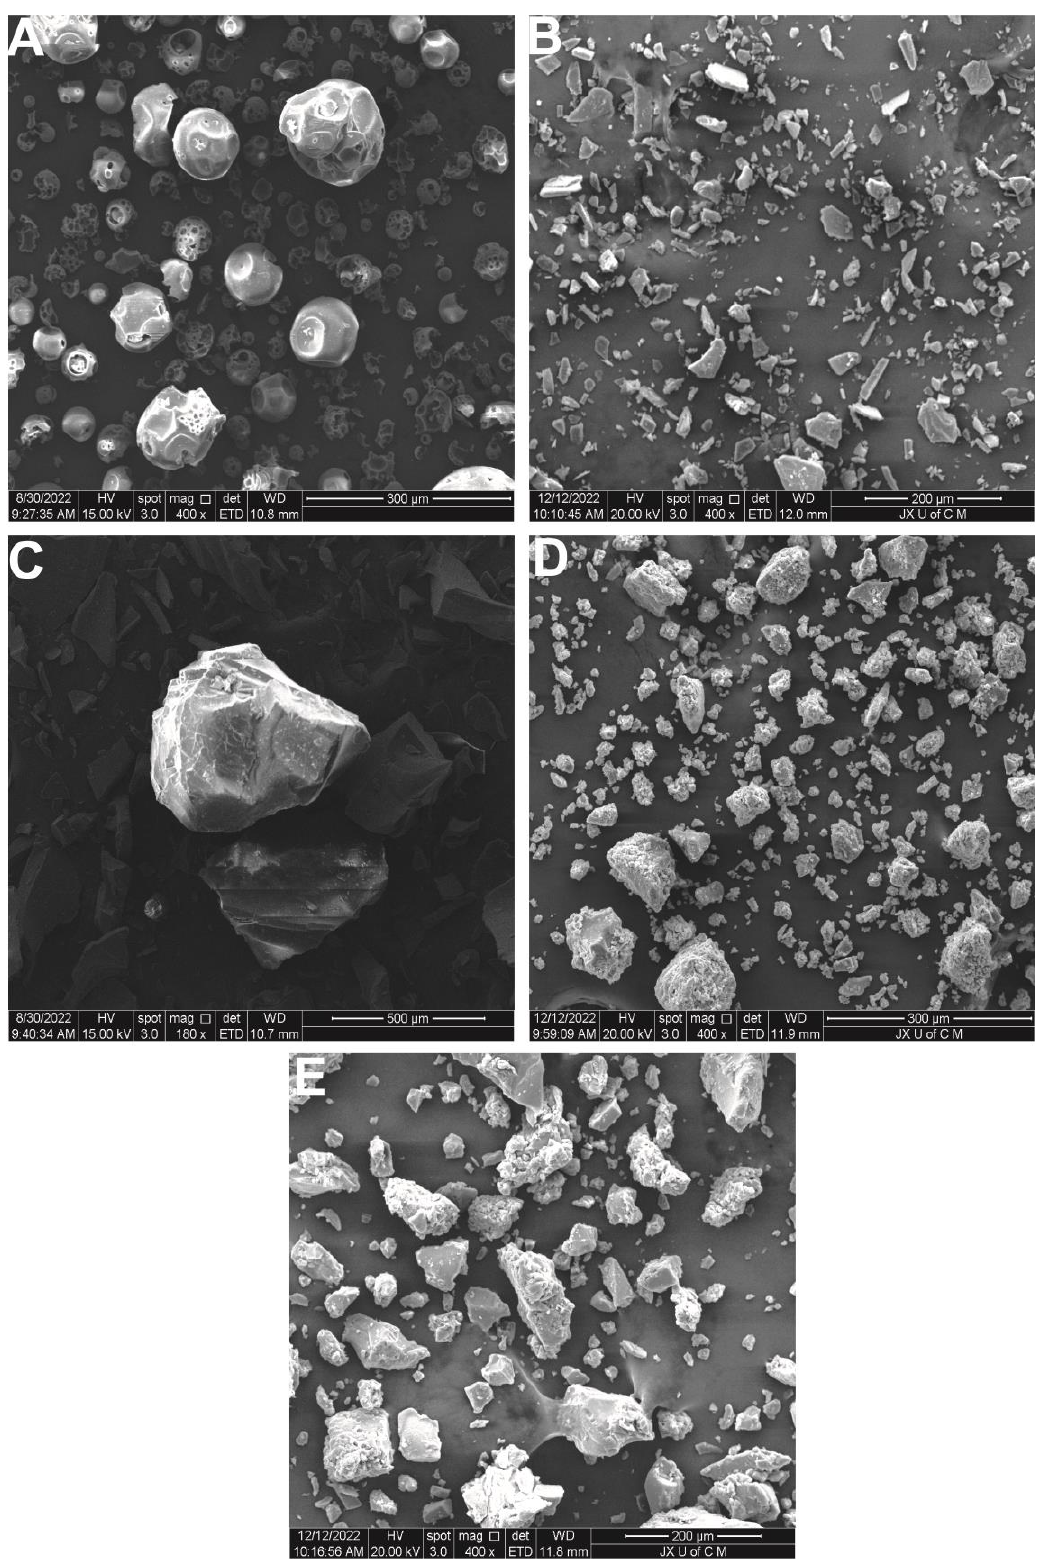
Figure 5. SEM images of HP-βCD ( A ), puerarin ( B ), PIC ( C ), unloaded hydrogels at 400× ( D ), and PIC -loaded hydrogels at 400× ( E ).